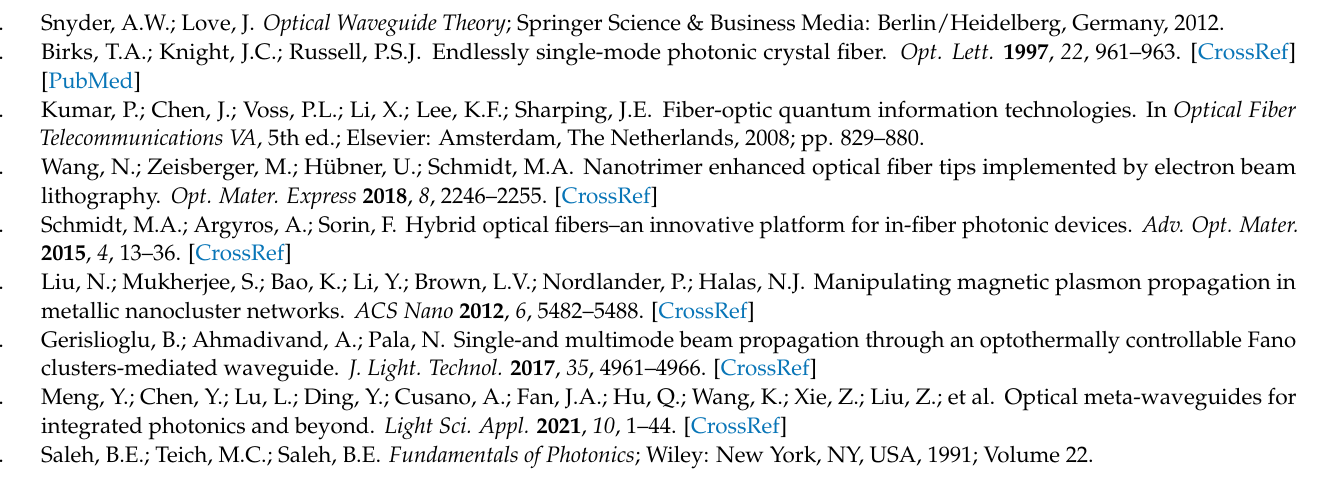
models; Figure S2: Bare waveguide-based coupling efficiencies; Figure S3: The coupling efficiencies of a grating-enhanced waveguide; Figure S4: Two full-wave simulations for a grating-patterned waveguide. Figure S5: The electromagnetic field distributions of grating-configured